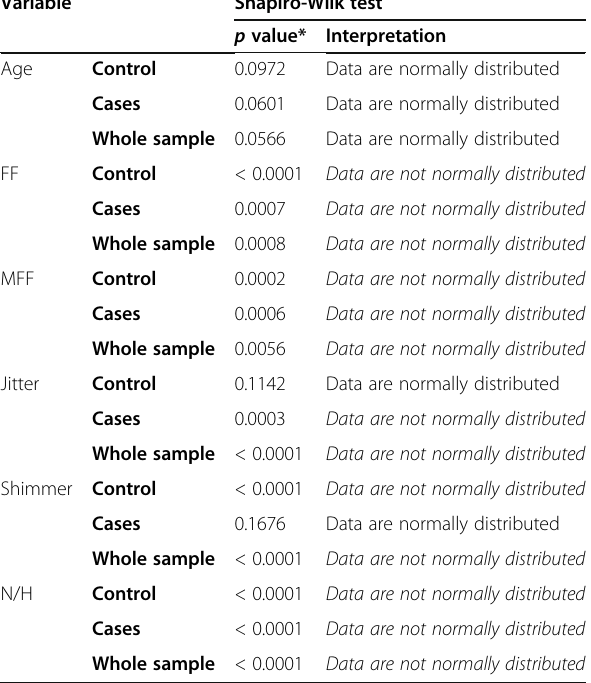
Table 3 Shapiro-Wilk test for normality for variables in both treatment